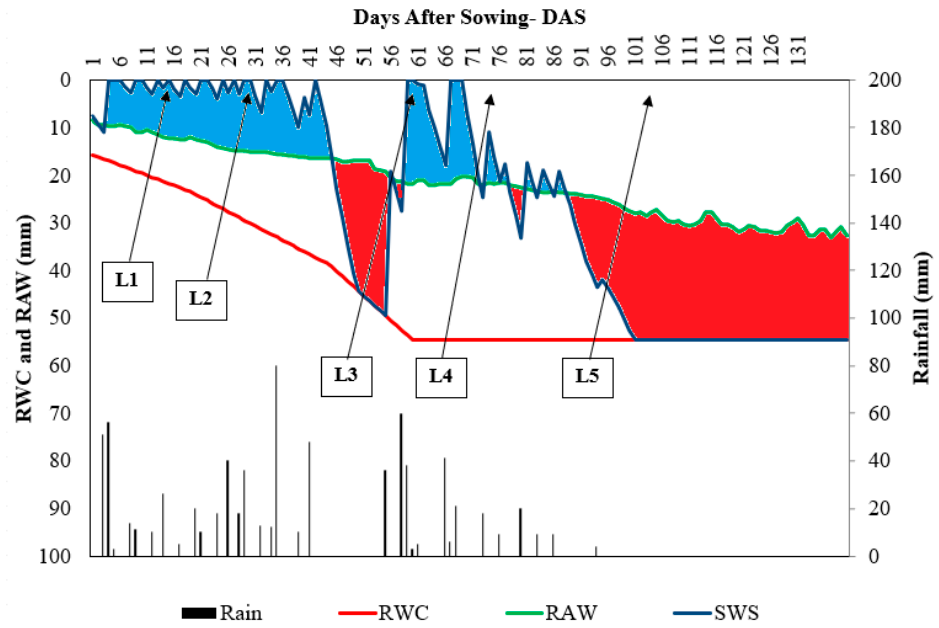
Figure 4. Soil water balance during off-season corn cultivation in rainfed conditions in a clayey soil of the Brazilian Cerrado in the 2019 season. RWC: Residual water content. RAW: readily available water. SWS: soil water storage. The arrows indicate the dates of the volumetric soil moisture readings (R). At physiological maturity (R 6 stage), corn hybrids were harvested, and then 1000-grain mass and grain yield were measured. All ears of corn in the plot’s effective area were cleaned and weighed, and grain yield (kg ha − 1 ) was estimated after correcting